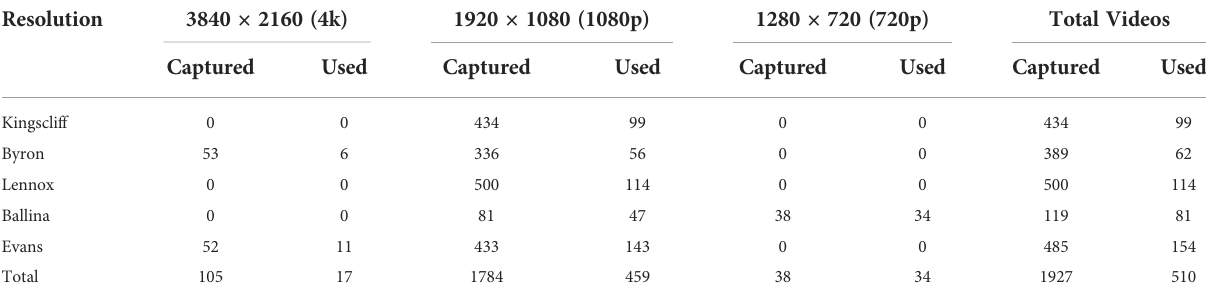
TABLE 1 Summary of the number of videos, their capture locations and capture resolution for the Shark AI Trial data used in this work. Resolution 3840 × 2160 (4k)